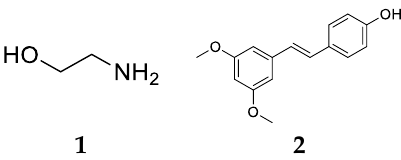
Figure 1 Structures of ( 1 ) ethanolamine (ETA), and ( 2 ) pterostilbene. Figure 1. Structures of ( 1 ) ethanolamine (ETA), and ( 2 )